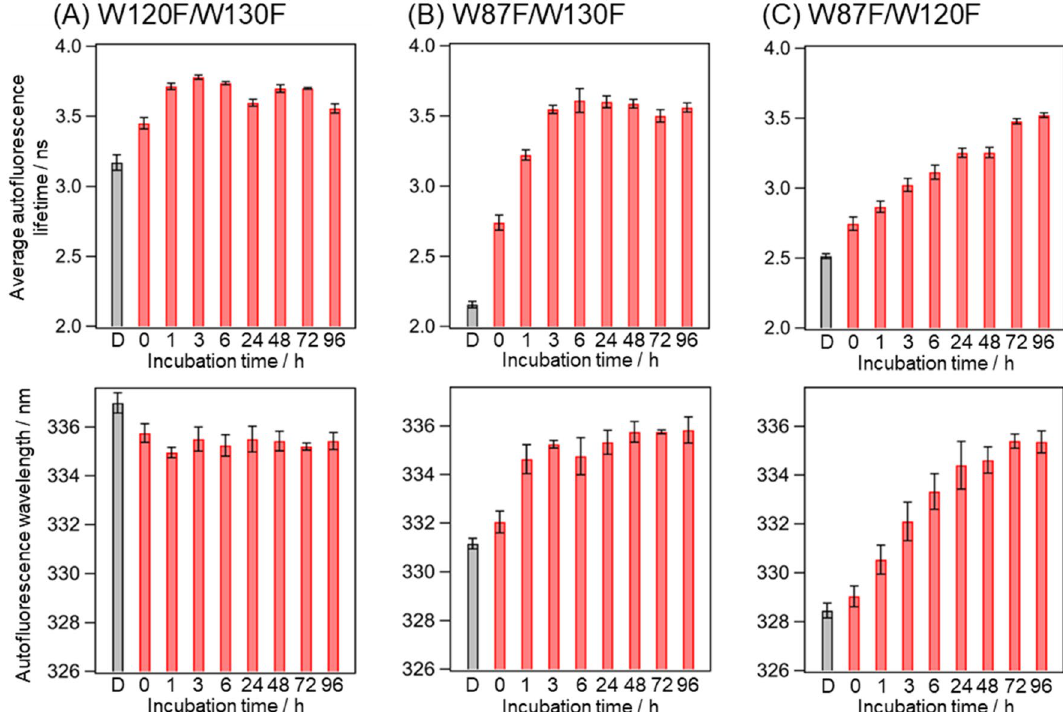
Figure 5. Average autofluorescence lifetimes and peak wavelengths of the autofluorescence spectra of ( A ) W120F/W130F, ( B ) W87F/W130F, and ( C ) W87F/W120F mutants of Q28 in the dispersed solution and droplets at various incubation times. Values below the bars are incubation times in hours. “D” below the bar indicates the dispersed solution. Error bars are SD (The numbers of replicates are summarized in Table S1).